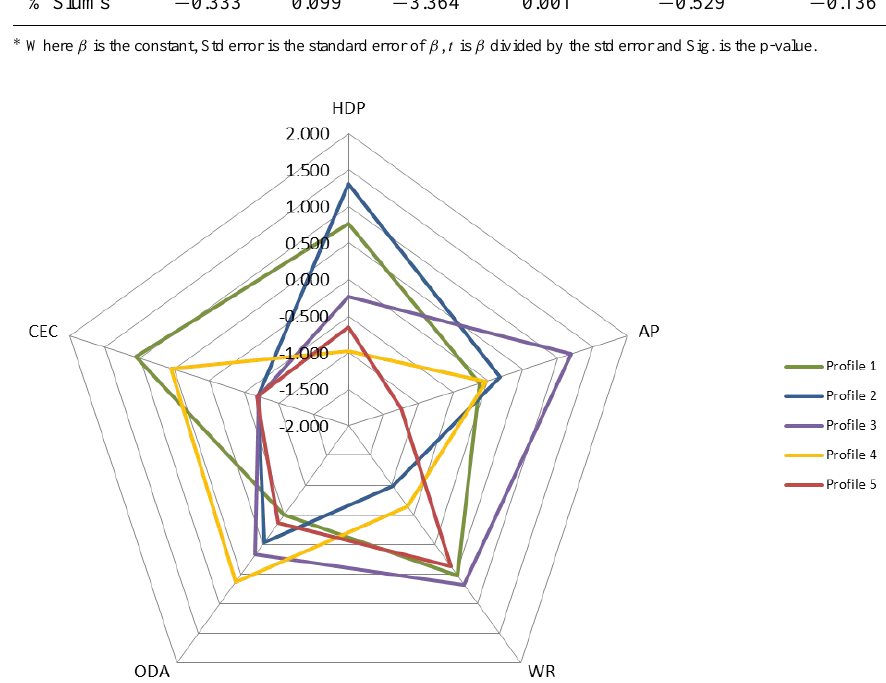
Fig. 3. The five country profiles. Each color shows the centroid of the class for each profile. HDP (D1) stands for Human Development against Poverty in the country, AP (D2) for Human Activity Pressure, WR (D3) for Water Resources, ODA (D4) for Official development Aid, and CEC for Country Environmental